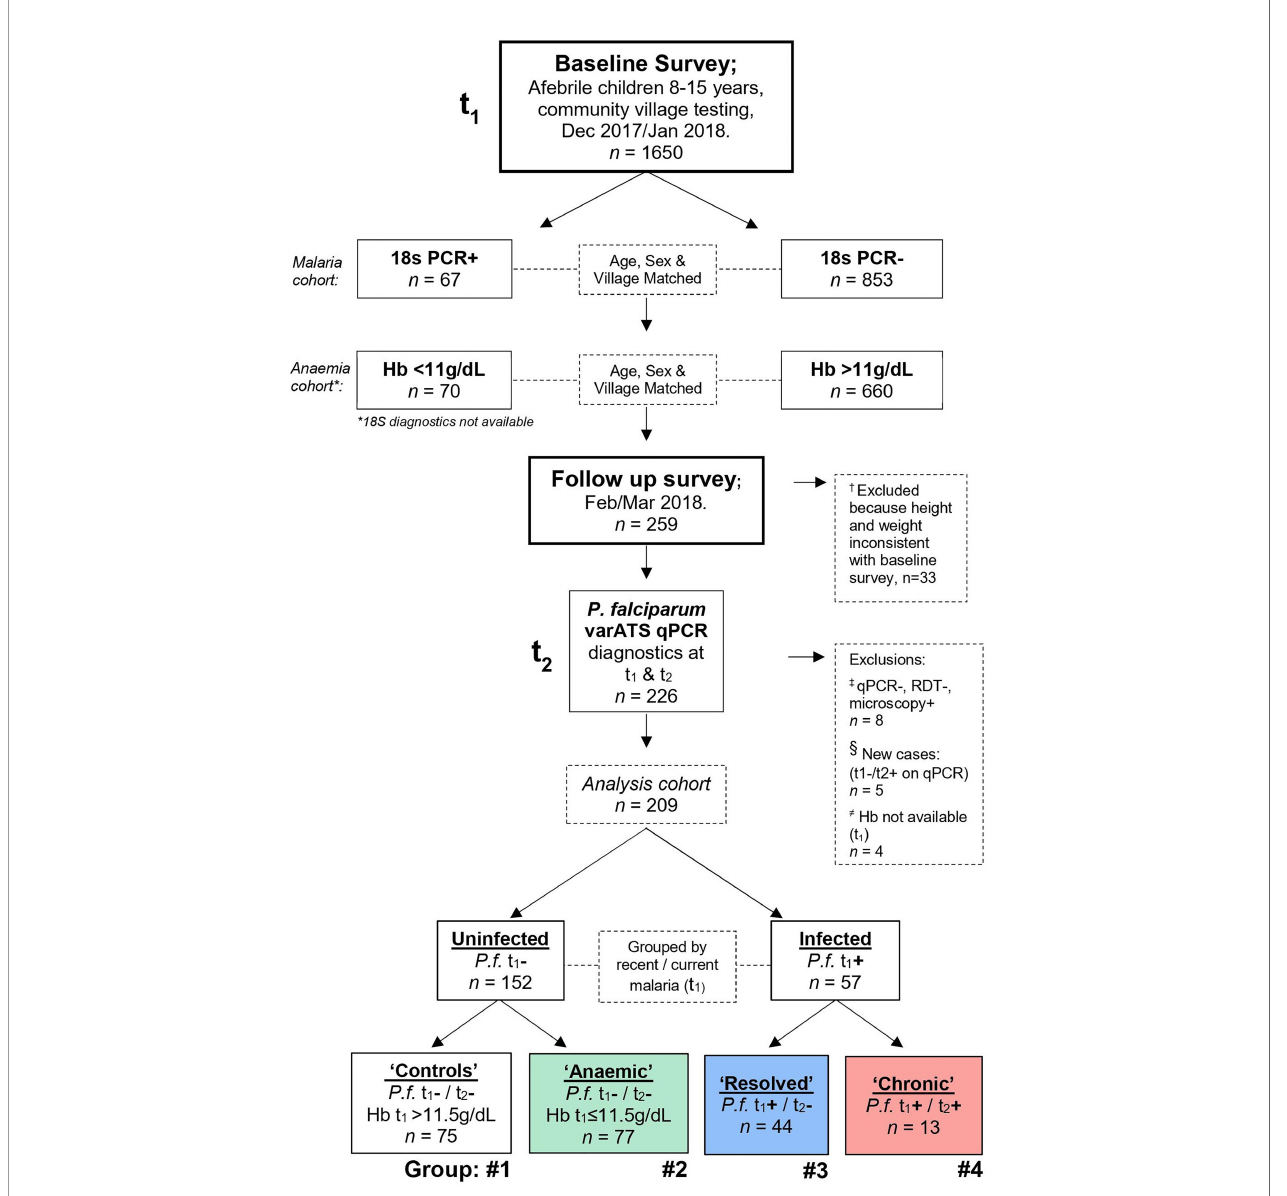
FIGURE 1 | Study design. A baseline cross-sectional fi eld survey was conducted during the beginning of the dry season, from December 2017 to January 2018 (time point 1, t 1 ) in the Upper River Region of The Gambia. 1650 children were recruited, and blood sampled by fi nger prick. Based on initial diagnostics completed at the time [ P. falciparum 18S PCR or haemoglobin (Hb)], 333 children were identi fi ed for recall in the follow up survey. This broad group included all identi fi ed P. falciparum positive children and those with anaemia (Hb <11 g/dL); along with age-, sex- and village-matched controls in a 1:1 ratio or where suf fi cient controls where available a 1:2 ratio. Speci fi cally, 67 PCR+ and 126 PCR- children were identi fi ed from the fi rst 920 children sampled, and 70 anaemic children and 140 non-anaemic controls identi fi ed from the remaining pool of 730 children. Of these 333 children recalled, 259 accepted transport to Basse regional hospital between February and March 2018 (time point 2, t 2 ) and blood was collected by venepuncture. Upon comparing changes in patient height and weight between t 1 and t 2 , 33 children were excluded because they may not have participated in the baseline survey; 14 who decreased in height by more than 5cm and weight by more than 15%, 12 who increased in height by more than 10cm and weight by more than 20%, and 7 with no height and weight data available for comparison ( † ; see Materials and Methods and Table S3 ). Retrospectively, qPCR diagnostics were repeated for P.f. varATS and children were fi rst grouped by recent malaria infection at t 1 . Of the uninfected at t 1 ( n =156), children were further grouped by Hb concentration; non-anaemic ( n =75) and anaemic ( n =77), ( ≠ ) with 4 children excluded due to no Hb reading available. Of the children infected at t 1 ( n =57), 13 remained persistently infected and 44 had resolved their infection at recall (t 2 ). Children who were negative by qPCR and RDT, but positive by microscopy in t 1 were excluded ( ‡ ; Table S4 ). (§) Due to malaria transmission in The Gambia being highly seasonal, the fi ve children with acquired infections during the study period ( ‘ New ’ ) were excluded from further analysis, as these were unlikely to be locally acquired. Thus, the four groups were: #1 Uninfected ‘ Controls ’ , #2 Uninfected ‘ Anaemic ’ controls, #3 ‘ Resolved ’ (those who were positive at t 1 and negative by t 2 ) and #4 ‘ Chronic ’ (those who maintained infections throughout both study time